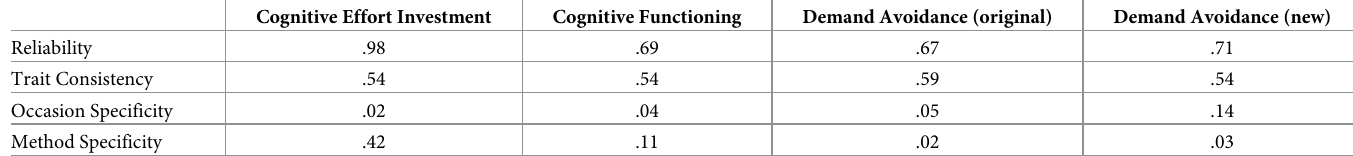
Table 4. Parameters of latent state-trait